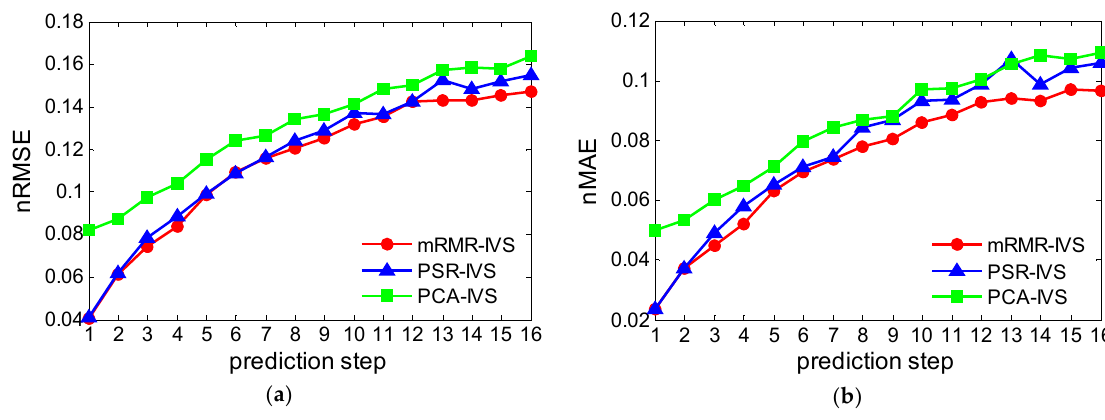
Figure 7. Error trend in different prediction steps of Anzishan farm: ( a ) nRMSE of test month; and ( b ) nMAE of test month.